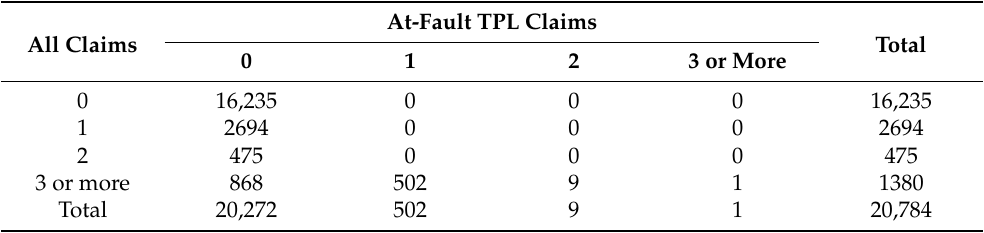
Table 2. Cross-table with the total number of claims (rows) and at-fault third-party liability (TPL) claims (columns) per insured during the seven observed months in 2018 and 2019.